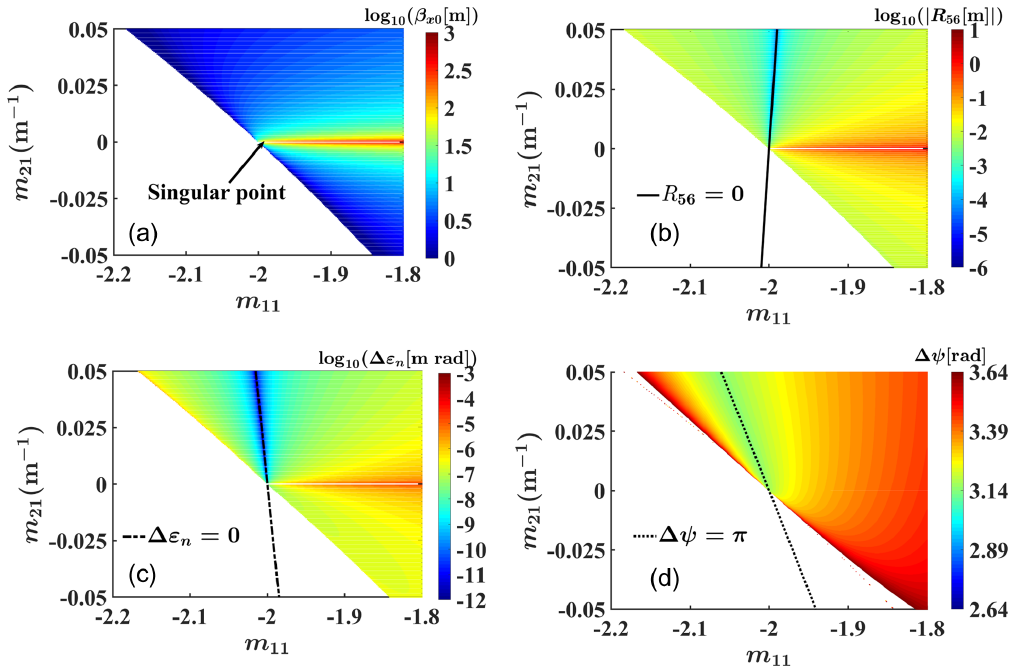
FIG. 3. (a) The horizontal beta function at the start point of the TBA, β x 0 . (b) The value of R 56 (the solid line shows R 56 ¼ 0 ). (c) The value of CSR-induced emittance growth (the chain-dotted line shows Δ ε n ¼ 0 ). (d) The value of the phase advance between the adjacent dipoles (the dotted line shows Δ ψ ¼ π ).